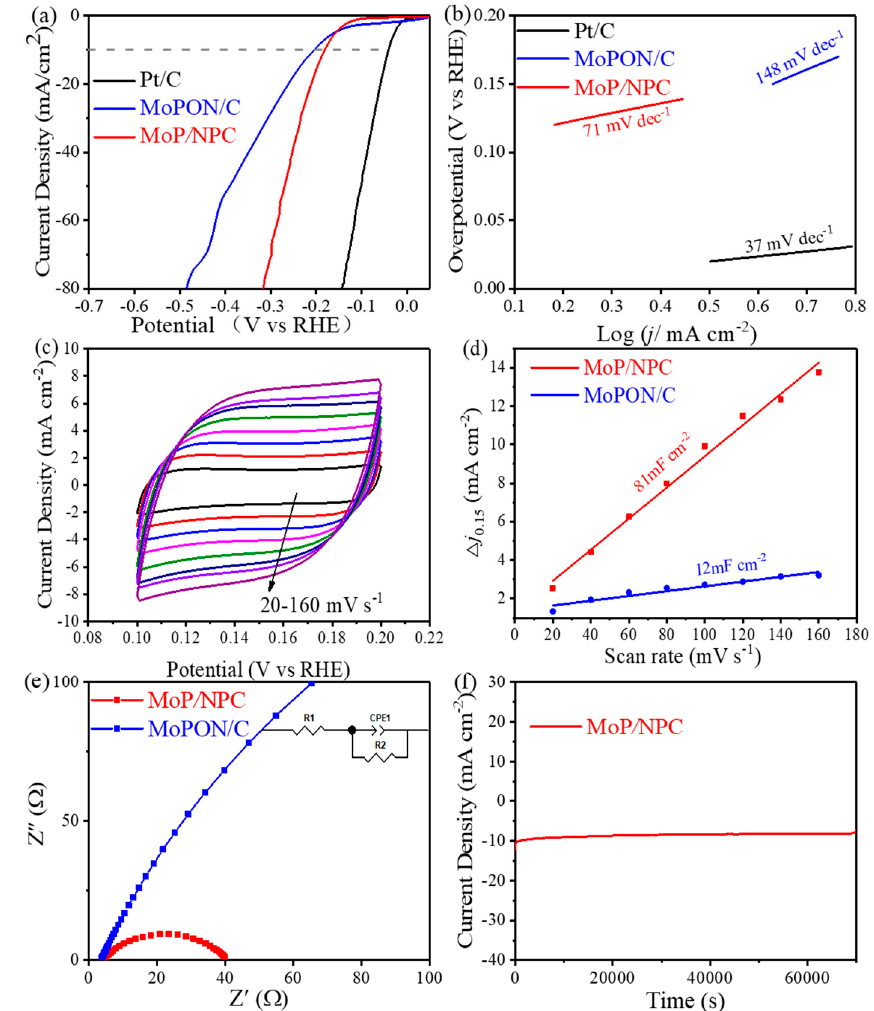
Figure 4. ( a ) Polarization curves of MoPON/C, MoP/NPC, and Pt/C in 0.5 M H 2 SO 4 ; ( b ) Tafel plots of MoPON/C, MoP/NPC, and Pt/C in 0.5 M H 2 SO 4 ; ( c ) CVs for MoP/NPC with different rates from 20 to 160 mV s − 1 ; ( d ) the capacitive currents plotted as a function of scan rate; ( e ) Nyquist plots of electrochemical impedance spectra (EIS) of MoP/NPC and MoPON/C recorded in 0.5 M H 2 SO 4 . Inset: one-time-constant model equivalent circuit used for data fitting of EIS spectra (R1 is the overall series resistance, CPE1 is the constant-phase element and resistance related to surface porosity, R2 is the charge-transfer resistance related to HER process); ( f ) time-dependent current density curve of MoP/NPC under a static overpotential of 0.18 V for 19